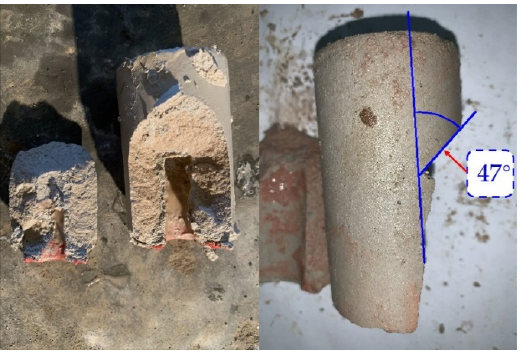
Figure 9. Fracture morphology of the samples damaged in slurry fracturing test [17].